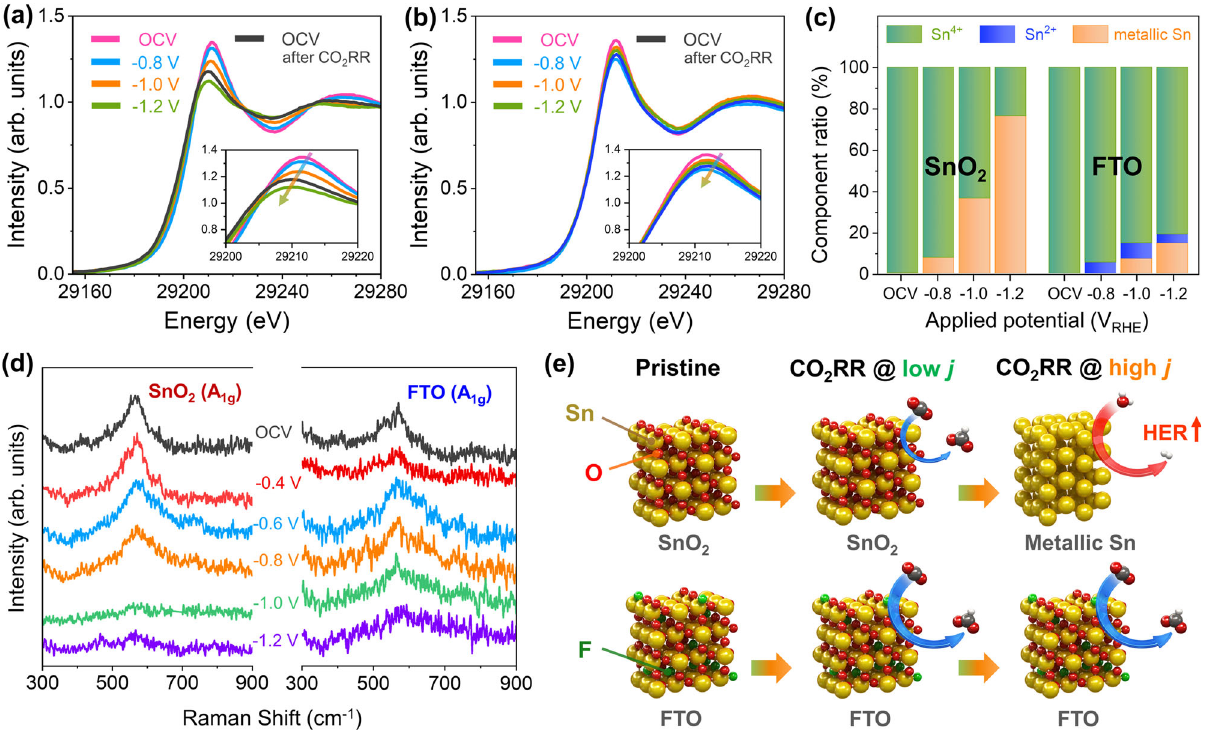
Fig. 4 In-situ/operando spectroscopy analyses for raveling origin of durability. a , b In-situ/operando Sn k-edge XANES spectra for a SnO 2 /C and b FTO/C catalysts during CO 2 RR in the fl ow-type electrolyzer and c its oxidation state distribution deconvoluted by linear combination fi tting (orange: Sn, blue: Sn 2 + , and green: Sn 4 + ). d In-situ/operando SER spectra obtained at constant potentials for SnO 2 and FTO catalysts without carbon supporter. Analyzed SER spectra present in the wavenumber region of 300 – 900 cm − 1 . e Schematic illustration of reaction af fi nity for SnO 2 and FTO under low/high cathodic